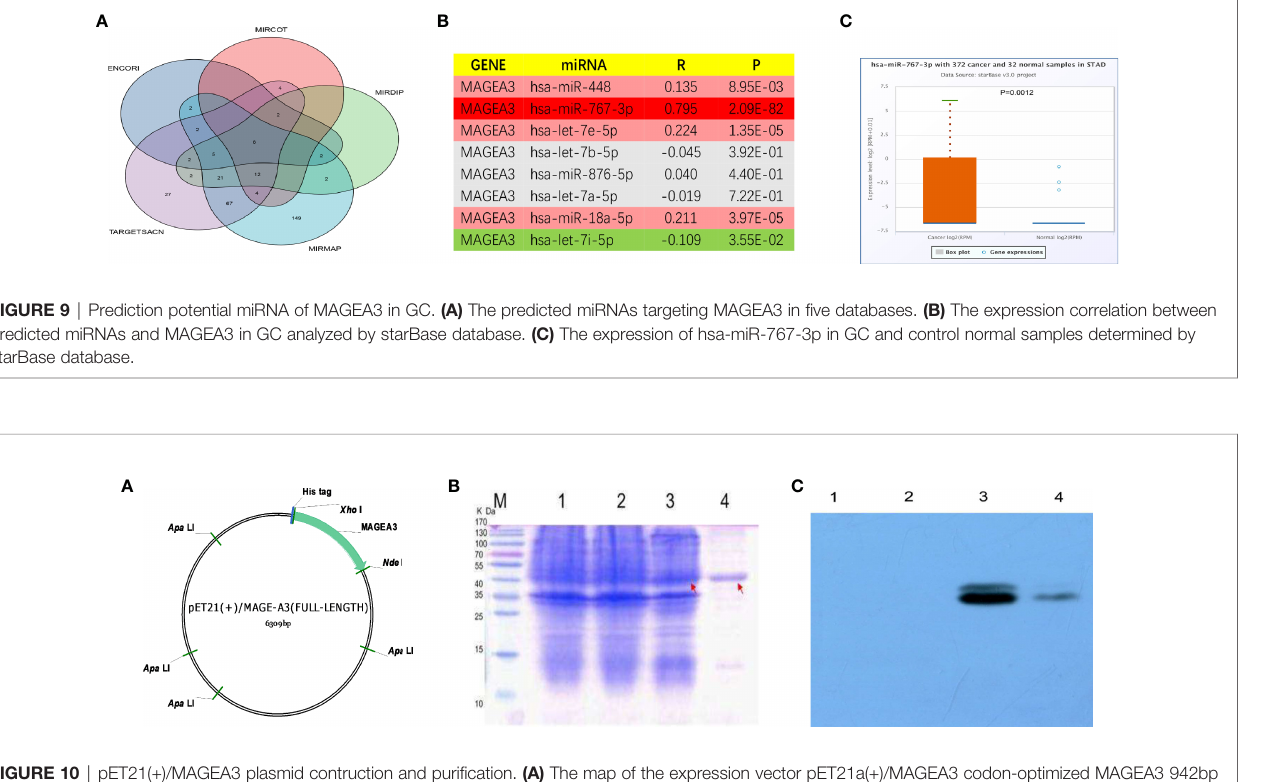
FIGURE 10 | pET21(+)/MAGEA3 plasmid contruction and puri fi cation. (A) The map of the expression vector pET21a(+)/MAGEA3 codon-optimized MAGEA3 942bp with 6xHis tag cloned into the prokaryotic expression vector pET21a(+) by NedI/XhoI restriction sites. (B) Af fi nity puri fi ed MAGE-A3 protein expressed from E. coli Rosetta were analyzed with SDS-PAGE. (C) Af fi nity puri fi ed MAGE-A3 identi fi ed by western blot with mouse anti-His mAb. Lane M: pre-stained protein marker; Lane 1, Rosetta; Lane 2, pET21a(+)/Rosetta; Lane 3, pET21a(+)/MAGE-A3 at 48 kDa; Lane4, puri fi ed MAGE-A3protein at 48